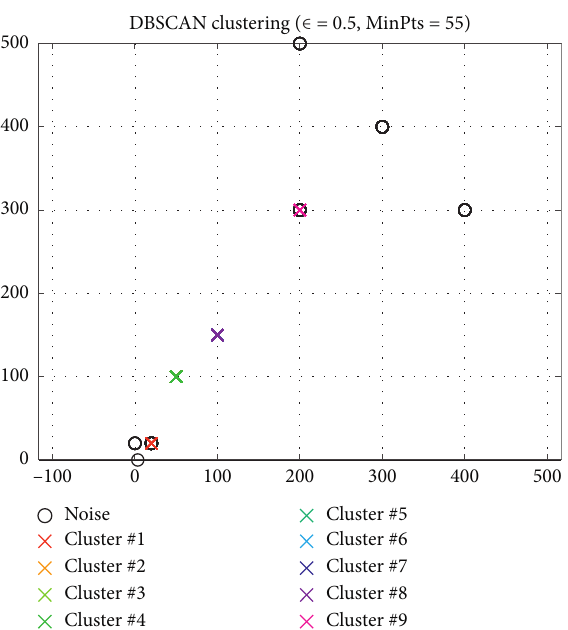
Figure 4: Implementation of the DBSCAN algorithm on our